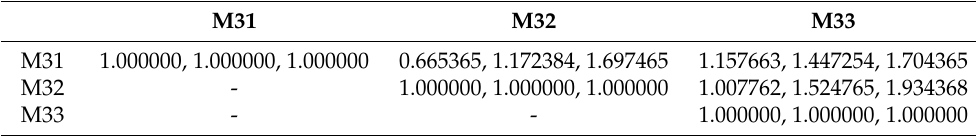
Table 7. Pair-wise fuzzy multi-criteria decision comparative matrix for targets.